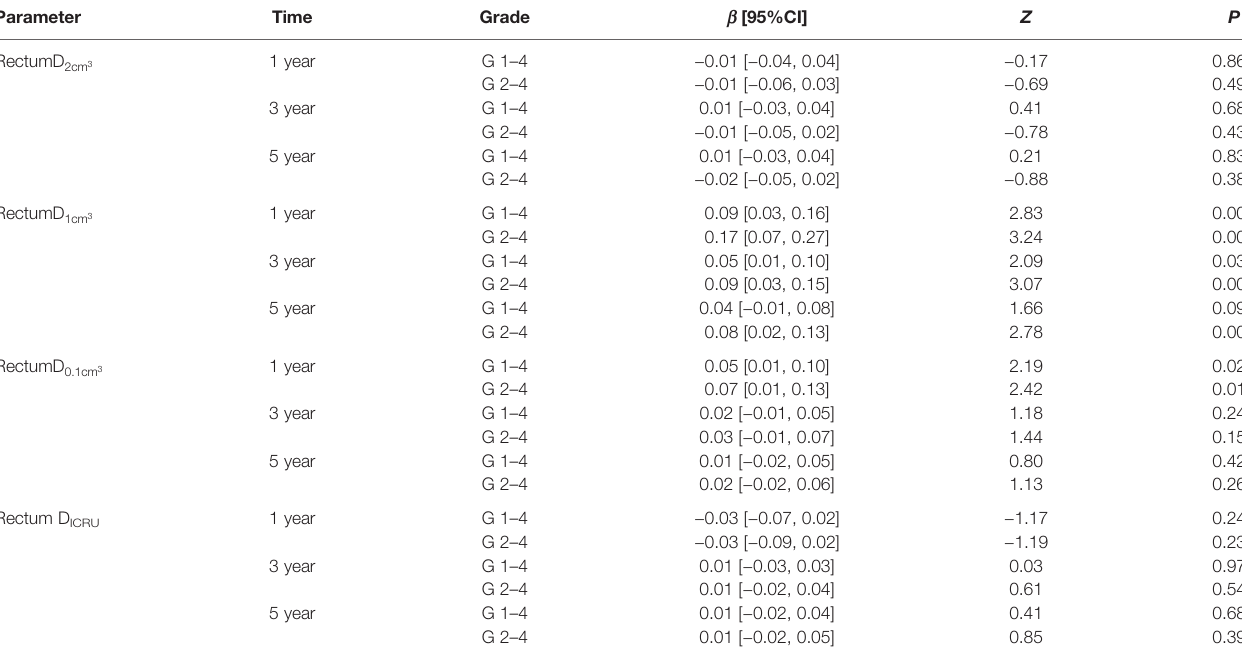
TABLE 3 | Probit model of relationships between D 2cm 3 ,D 1cm 3 ,D 0 : 1cm 3 , D ICRU for rectum and incidence of rectum morbidity grade 1 – 4, 2 – 4 at 1, 3, 5 years. Parameter Time